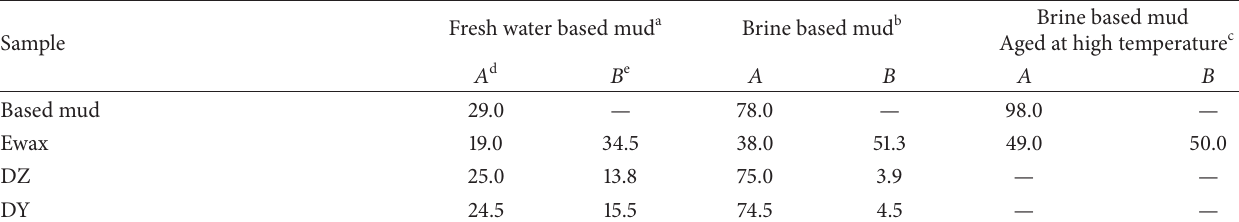
Table 4: Comparison of HTHP filtration loss control